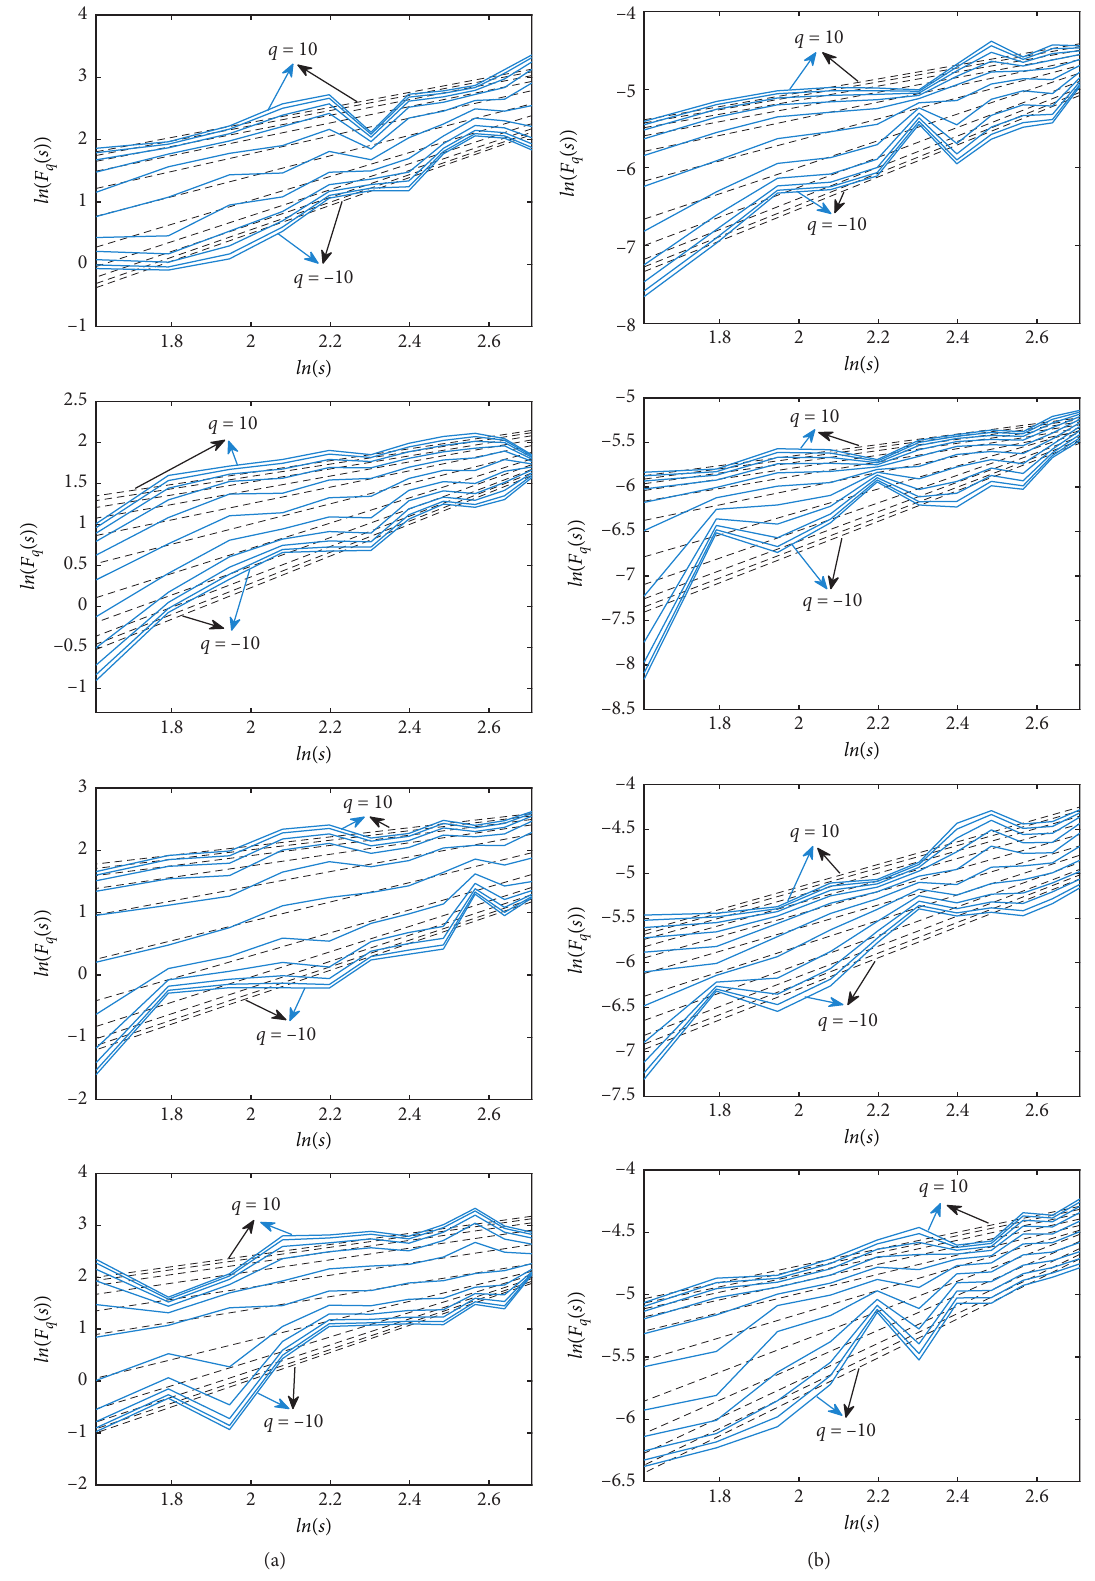
Figure 2: Log-log plots of fluctuation function F